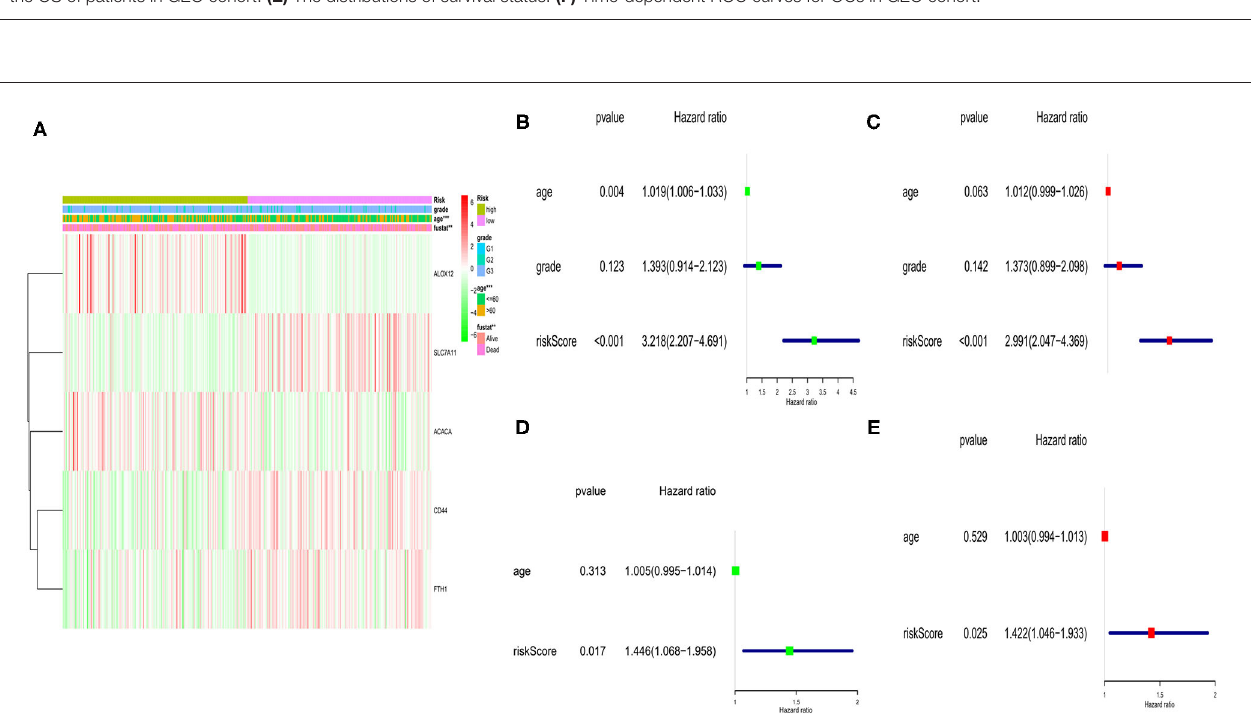
FIGURE 4 | Validation of risk signature for OCs in GEO cohort. (A) Risk score for OCs. (B) PCA plot for OCs. (C) t-SNE analysis for OCs. (D) Kaplan-Meier curves for the OS of patients in GEO cohort. (E) The distributions of survival status. (F) Time-dependent ROC curves for OCs in GEO cohort.